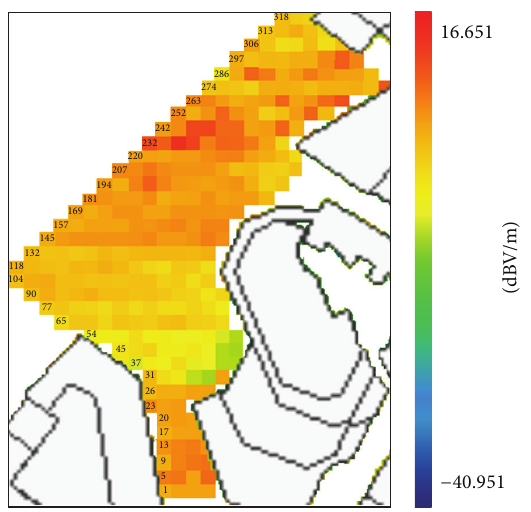
Figure 6: Total electric field strength measurements map.